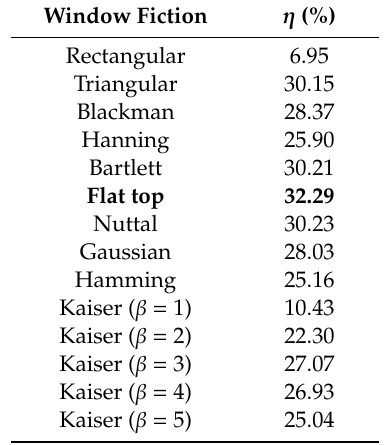
Table 2. The types of window function and their broken rotor bar (BRB) fault recognition capabilities in the simulation.